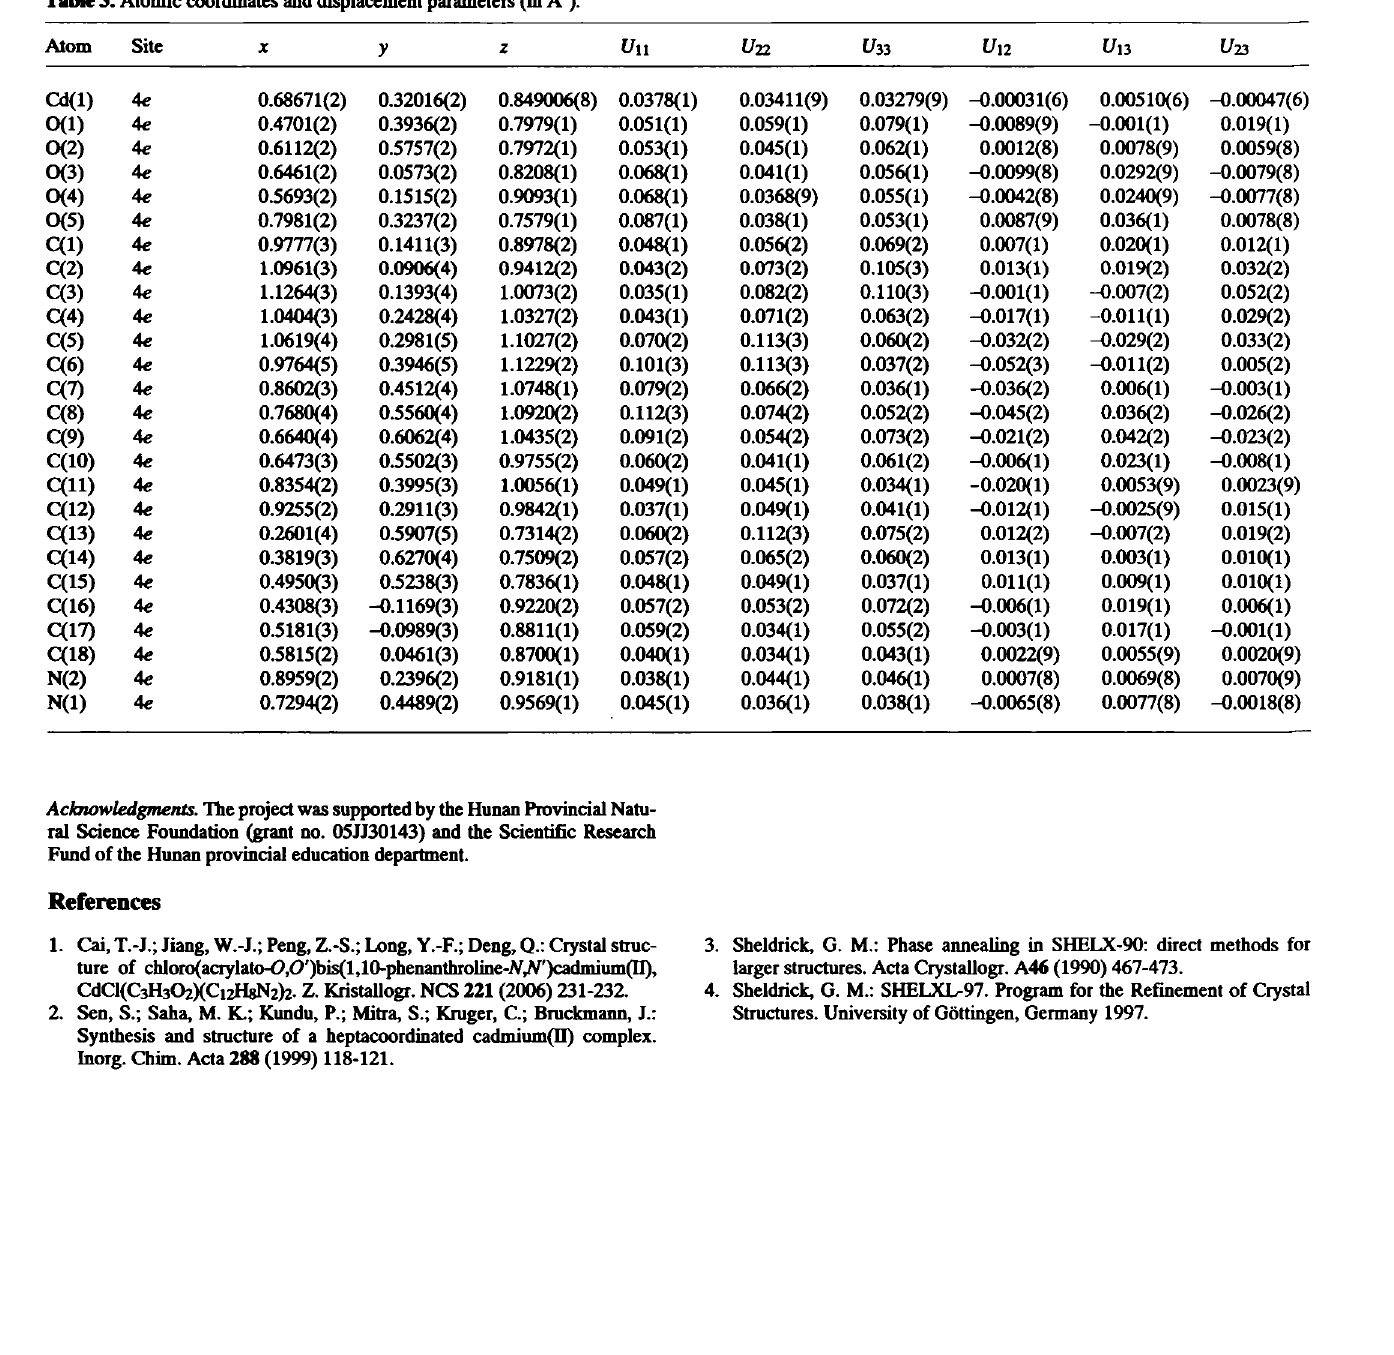
Table 3. Atomic coordinates and displacement parameters (in A 2